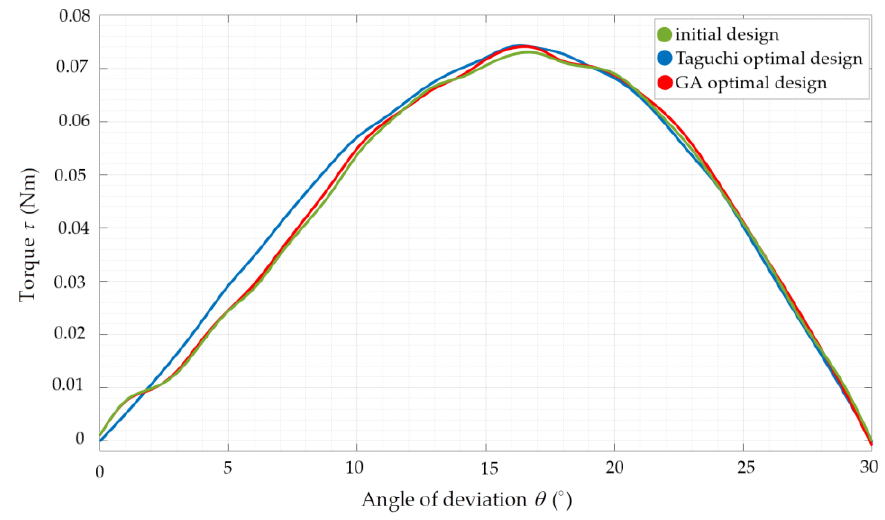
Figure 10. Comparison of three designs in terms of magnetic torque versus angle of deviation.